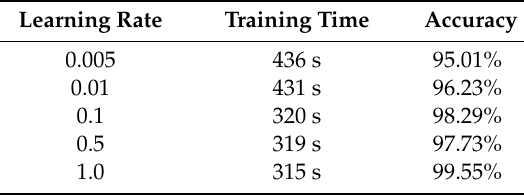
Table 2. The training results (time and accuracy) under di ff erent learning rates.